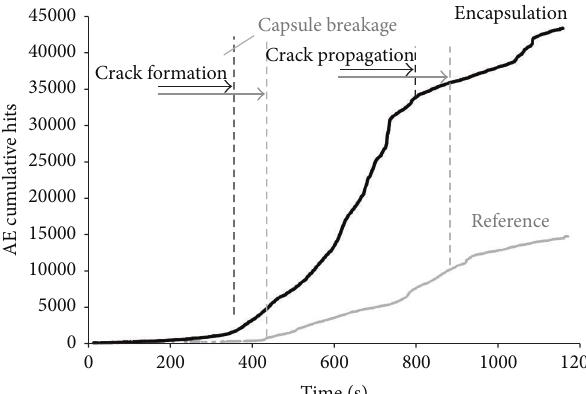
Figure 11: AE cumulative hits activity during testing for reference and encapsulation series.